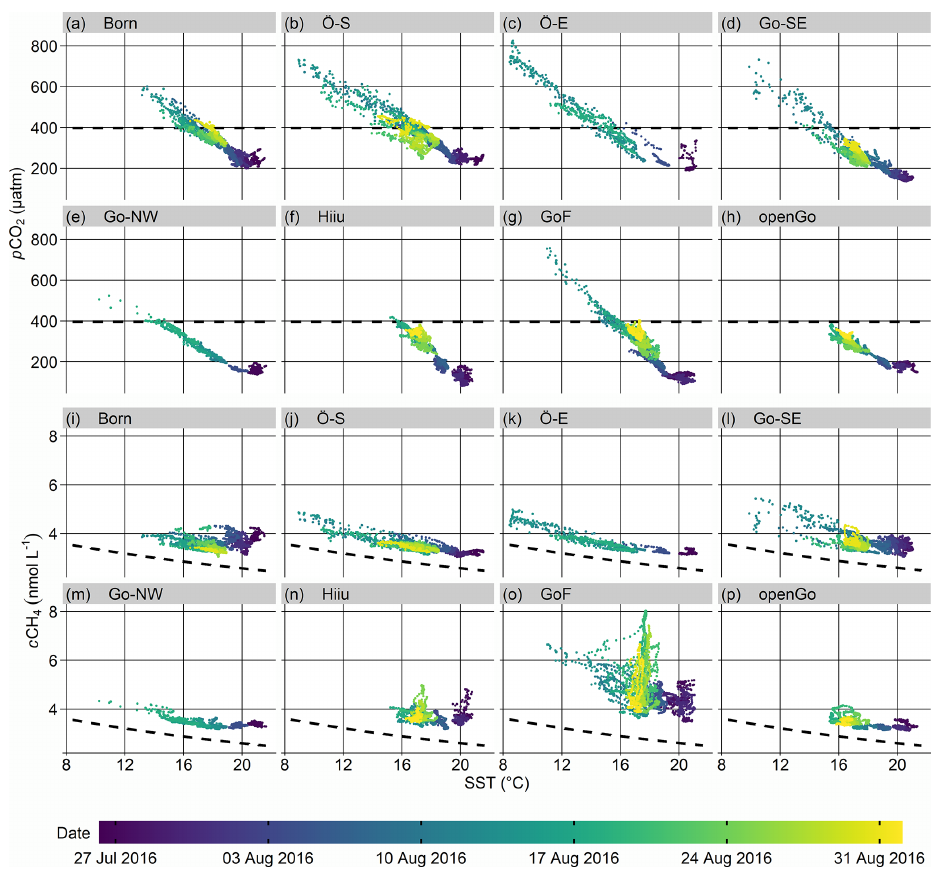
Figure 7. Surface p CO 2 (a–h) and c CH 4 (i–p) as measured by SOOP Finnmaid on 21 transects from 26 July to 30 August 2016, each plotted against SST within the seven upwelling regions and the open Gotland Sea box for comparison. The measurement date is colour-coded. Temporal coverage in the Go-SE box (15 transects; see black dashes in Fig. 4) and the Ö-E and Go-NW boxes (6 transects; see grey dashes therein) is reduced since SOOP Finnmaid uses two different routes around Gotland. Dashed black lines indicate atmospheric-equilibrium partial pressure for CO 2 and concentration for CH 4 (calculated using mean salinity per box in the given time period),